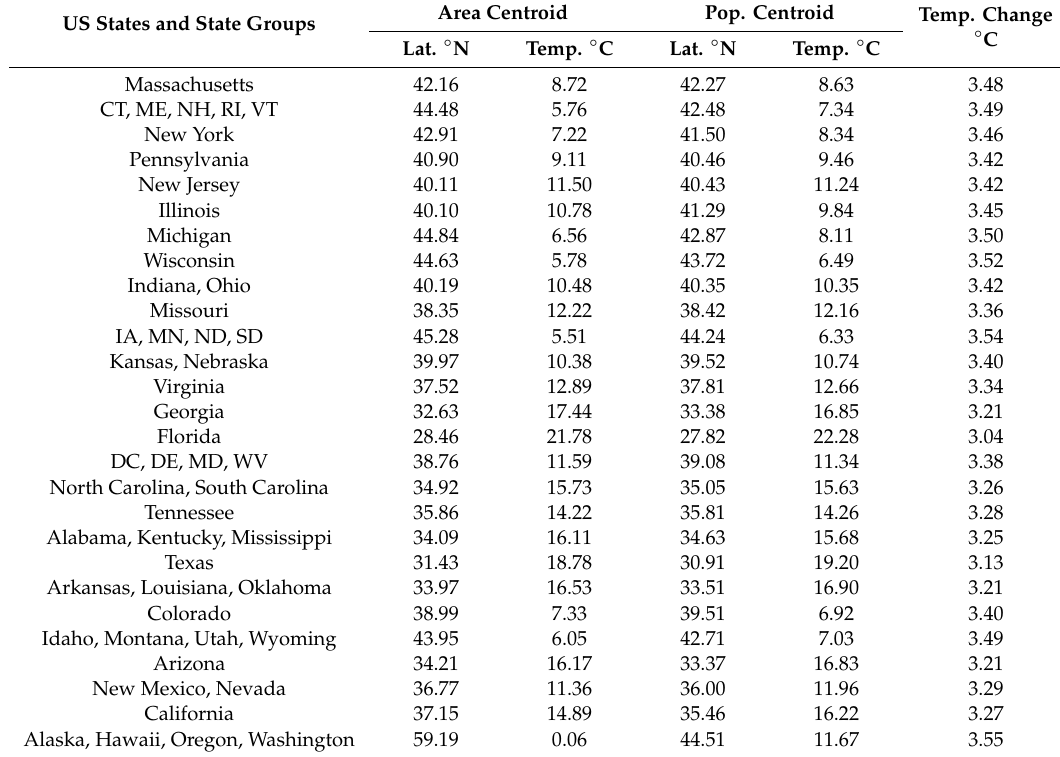
Table A3. Latitude and 2009 temperature at the area and population centroids, and temperature change at the population centroids at 3 ◦ C GMST increase, by states and state groups.